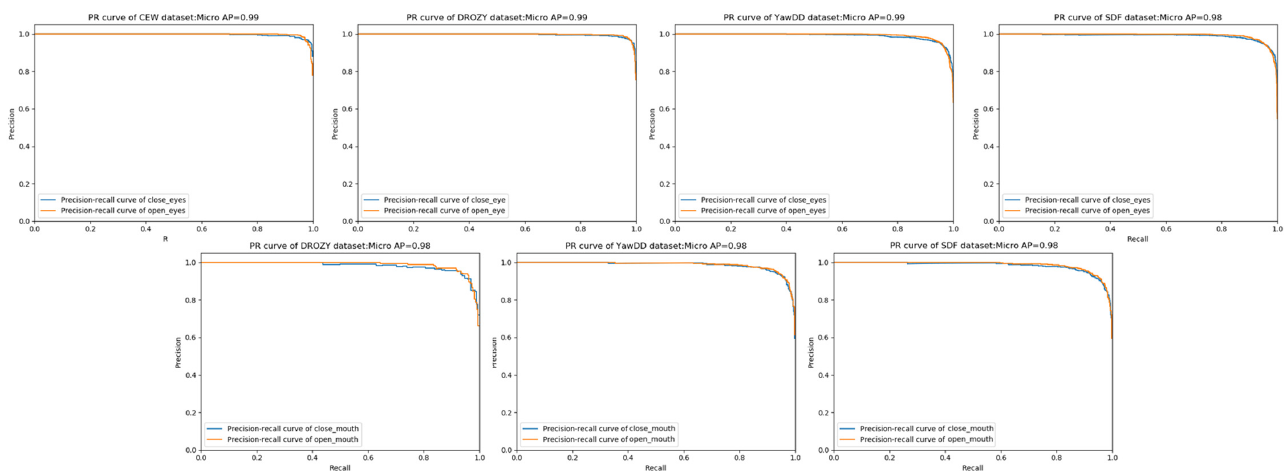
Figure 6. PR curves of the RCAN under four datasets.